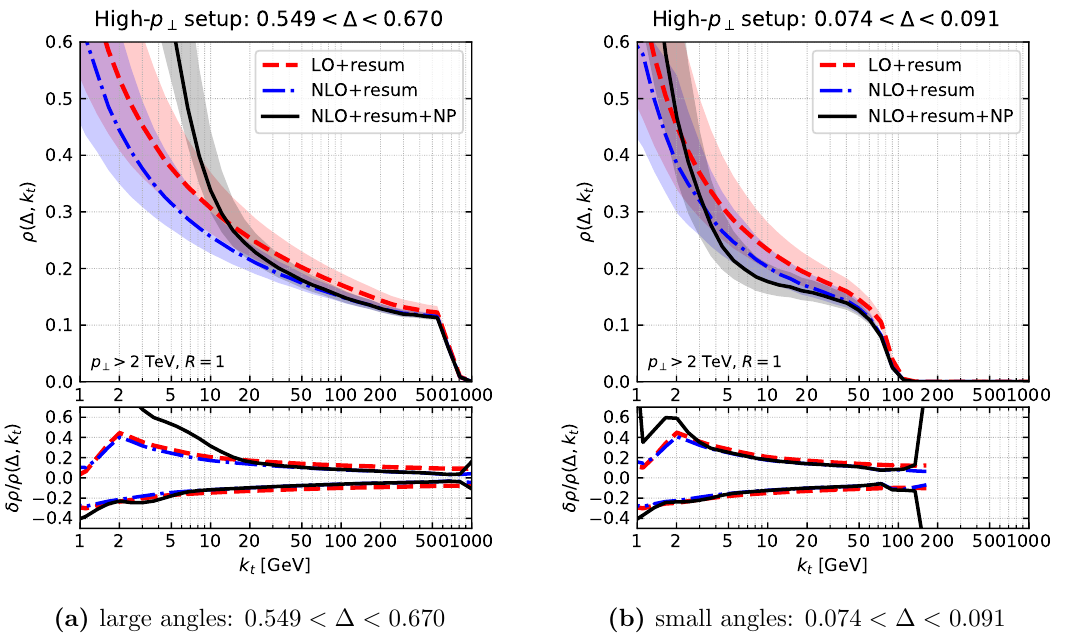
Figure 11. Slices of the primary Lund-plane density (cid:26) ((cid:1) ; k t ) at constant (cid:1). The upper panels correspond to the density (cid:26) ((cid:1) ; k t ) itself while the lower panels show the relative scale uncertainties (cid:14)(cid:26) ((cid:1) ; k t ). We show results for the matched result at LO (red) and NLO (blue), as well as NLO (cid:26) results including non-perturbative corrections